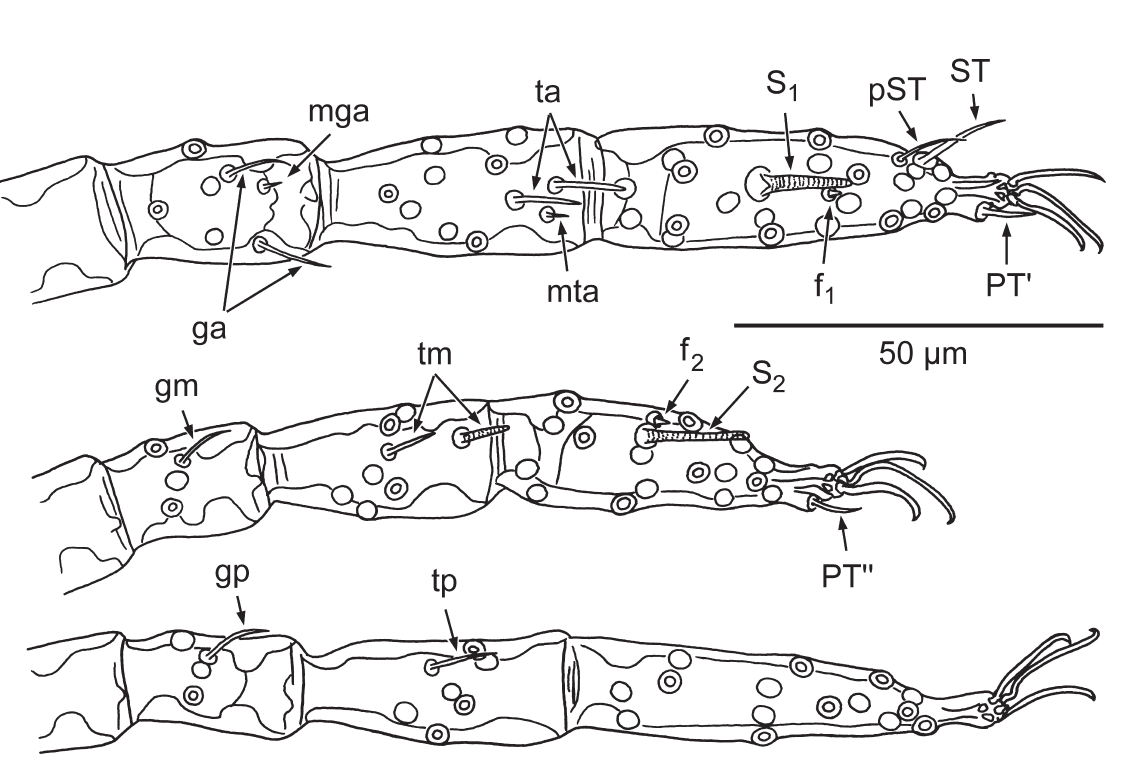
Fig. 4. Specialized setae of legs I, II and III of an example of Ericotrombidium sp. Double circles represent the bases of unspecialized tactile setae; single circles correspond to the unspecialized setae situated on the opposite side of the leg. Abbreviations: ga = genualae I (solenidia σ); mga = microgenuala I; ta = tibialae I (solenidia φ); mta = microtibiala I; S = tarsala I (solenidion ω); f = microtarsala I (famulus ε); 1 1 pST = parasubterminala; ST = subterminala (eupathidium ζ); PTʹ = pretarsala I (eupathidium ζ); gm = genuala II; tm = tibialae II; f = famulus II; S = tarsala II; PTʺ = pretarsala II; gp = genuala III; tp 2 2 = tibiala